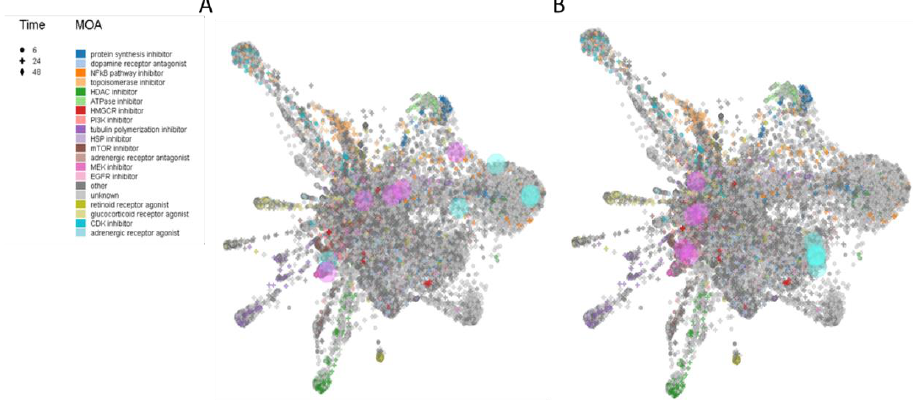
Figure 5. L1000FDW visualization of drug-induced signature. Input genes are represented by the significantly upregulated and downregulated genes obtained from the analysis of the GSE117589 dataset, for iPSC-derived NP cells ( A ) and neuronal cells ( B ). Blue and red circles identify drugs with similar and anti-similar signatures. Dots are color-coded based on the Mode of Action (MOA) of the respective drug. Table 1. List of biomarkers identified by DAM analysis in iPSC-derived NP cells 1 . Table 3. Potential anti-AD drugs identified by the L1000FWD analysis using the iPSC-derived NP cells model of